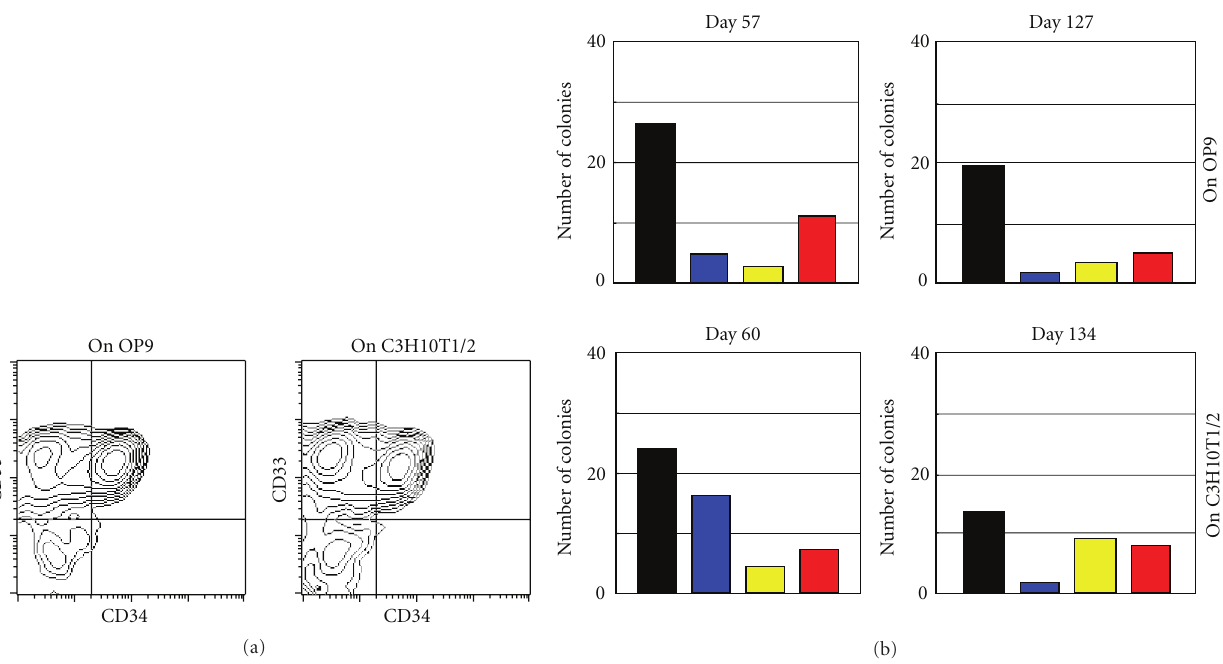
Figure 3: Characterization of cultured cells. (a) Flow cytometric analysis of detached cells produced in cultures on OP9 (Exp-OP9-A) and C3H10T1/2 (Exp-10T1/2-A) feeder cells and collected on Day 218 of culture. The detached cells were stained for CD33, a marker specific for granulocyte/macrophage lineage cells, and CD34, a marker specific for hematopoietic stem/progenitor cells. Flow cytometric analyses of detached cells from other experiments showed similar results. (b) Colony-formation assays. Detached cells produced in culture on OP9 feeder cells (Exp-OP9-A) were collected on Days 57 and 127 of culture. Similarly, detached cells produced in culture on C3H10T1/2 feeder cells (Exp-10T1/2-D) were collected on Days 60 and 134 of culture. The cell samples were used in a standard colony-formation assay. Black bars: colony-forming unit of monocyte/macrophage lineage cells, CFU-M. Blue bars: colony-forming unit of granulocyte lineage cells, CFU- G. Yellow bars: colony-forming unit of granulocyte and monocyte/macrophage lineage cells, CFU-GM. Red bars: burst-forming unit of erythroid cells, BFU-E. Similar results were obtained in colony-formation assays using detached cells from other